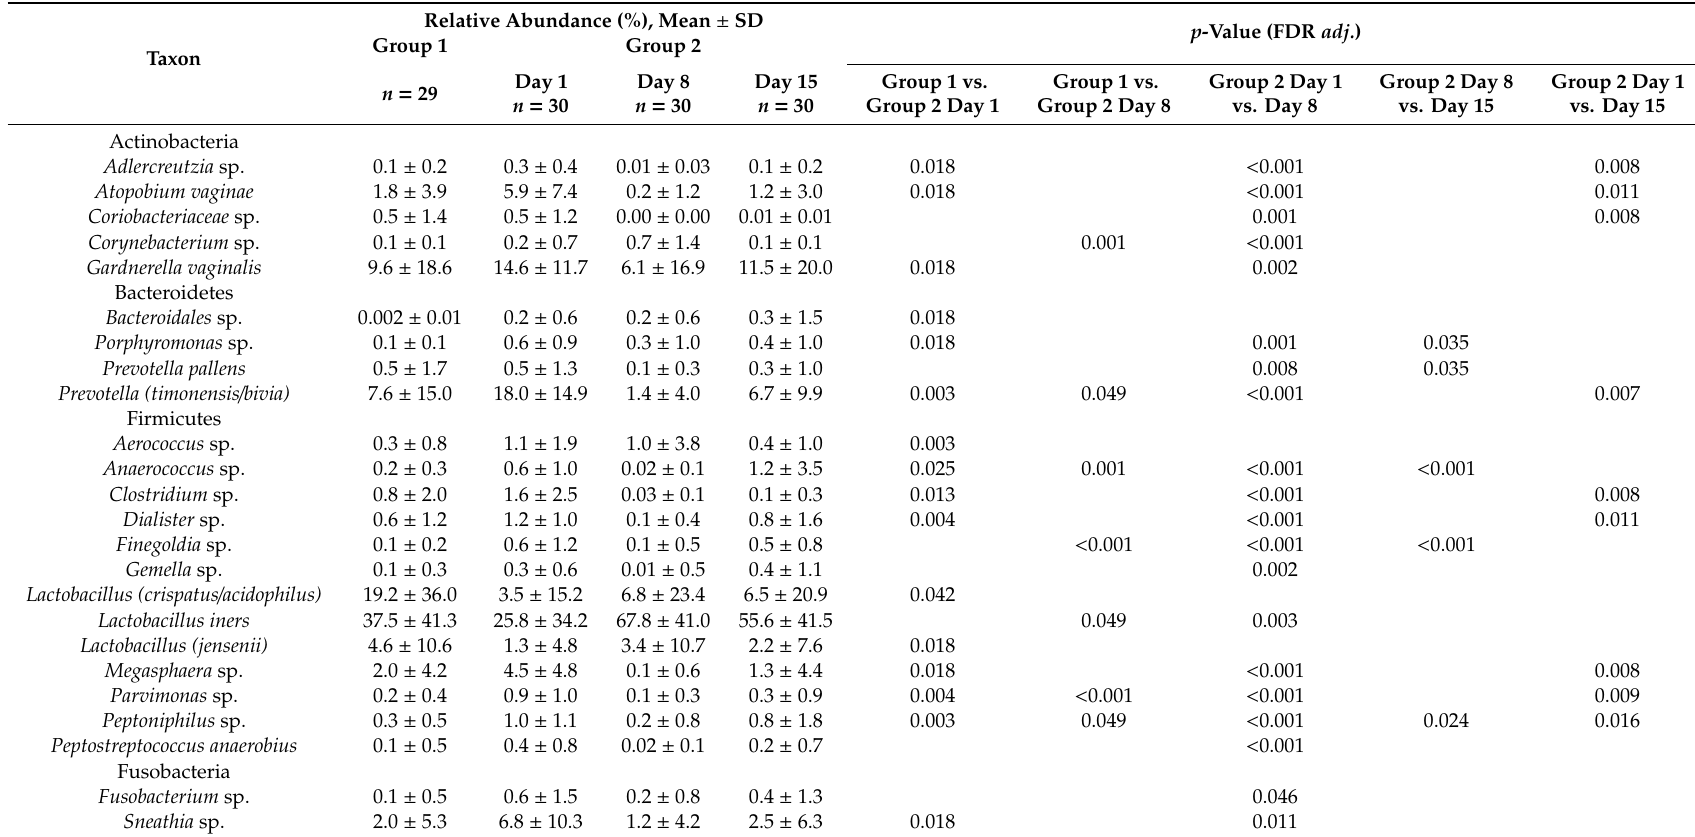
Relative Abundance (%), Mean ± SD p -Value (FDR adj. ) Group 1 Group 2 Day 1 Day 8 Day 15 Group 1 vs. Group 1 vs. Group 2 Day 1 Group 2 Day 8 Group 2 Day 1 n = 29 n = 30 n = 30 n = 30 Group 2 Day 1 Group 2 Day 8 vs. Day 8 vs. Day 15 vs. Day 15